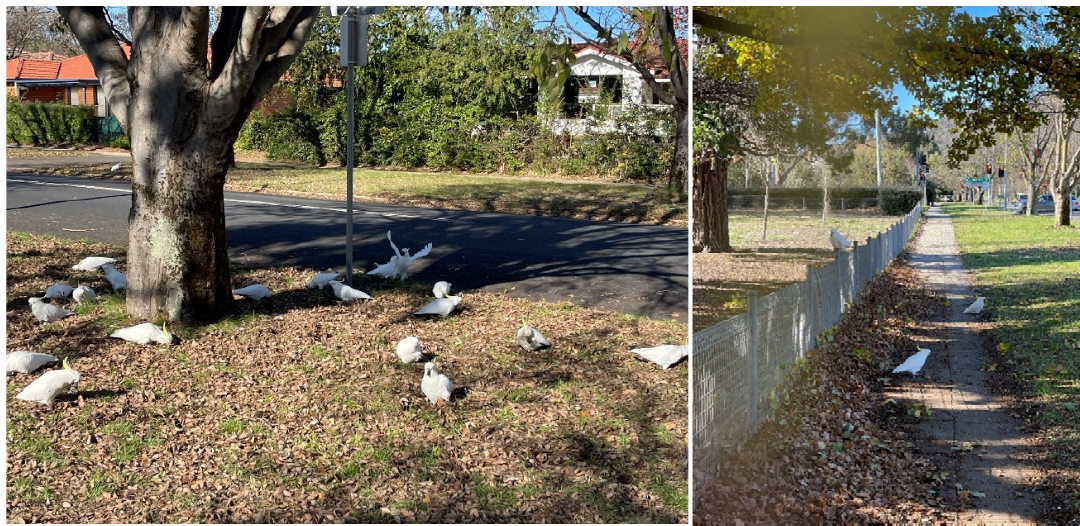
Figure 4. Bird habitat on the street trees and verges in a residential suburb in Canberra. Photos: F. Mofrad, 2022.